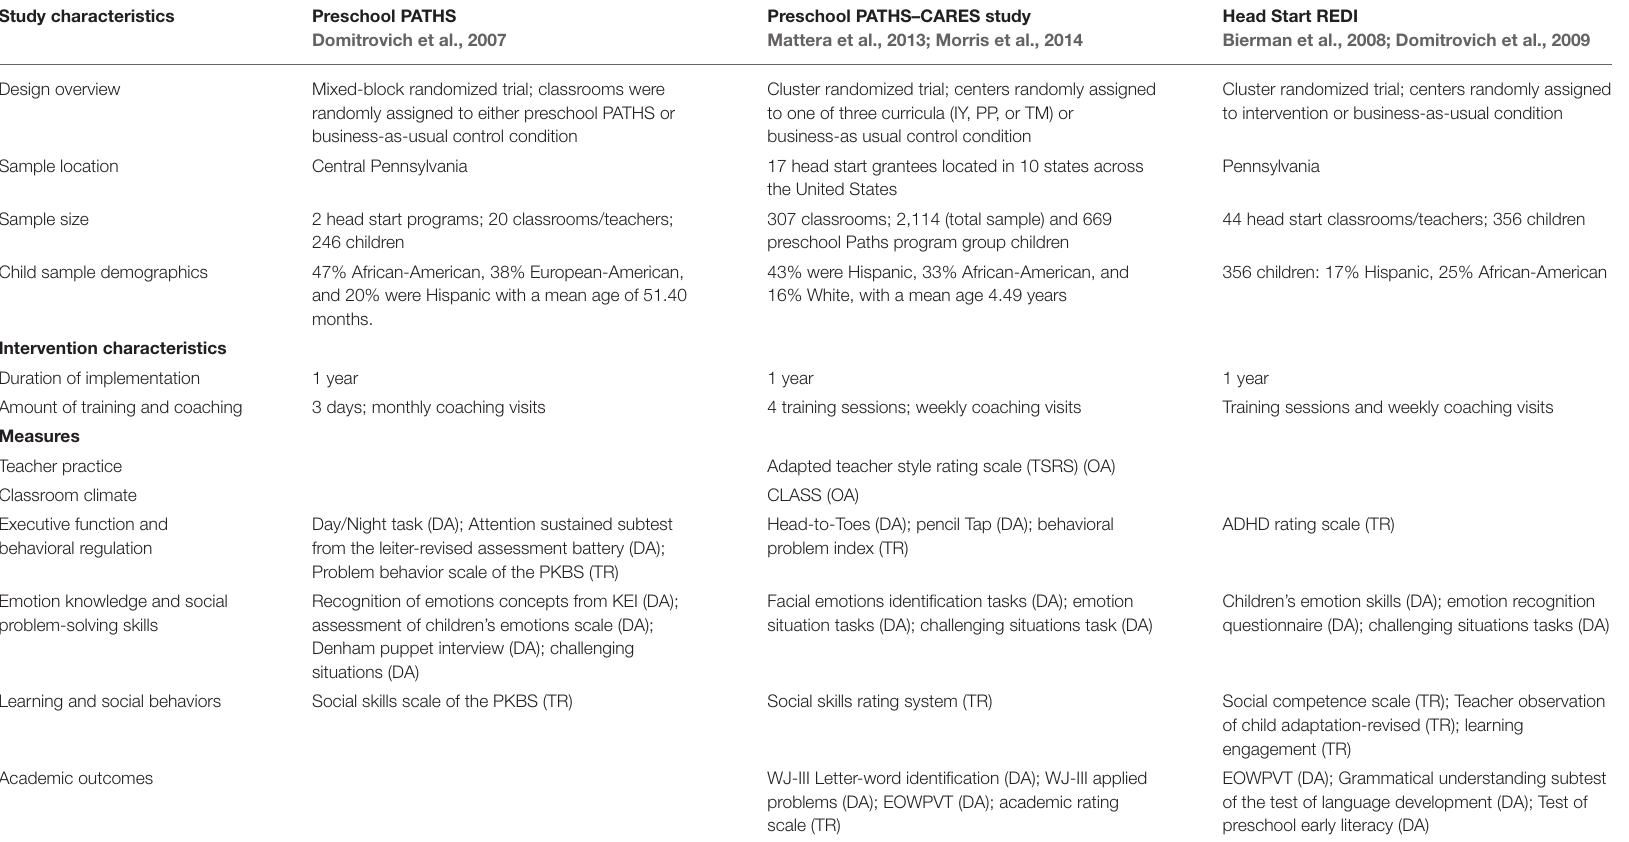
TABLE 2 | Background characteristics of the social-emotional learning